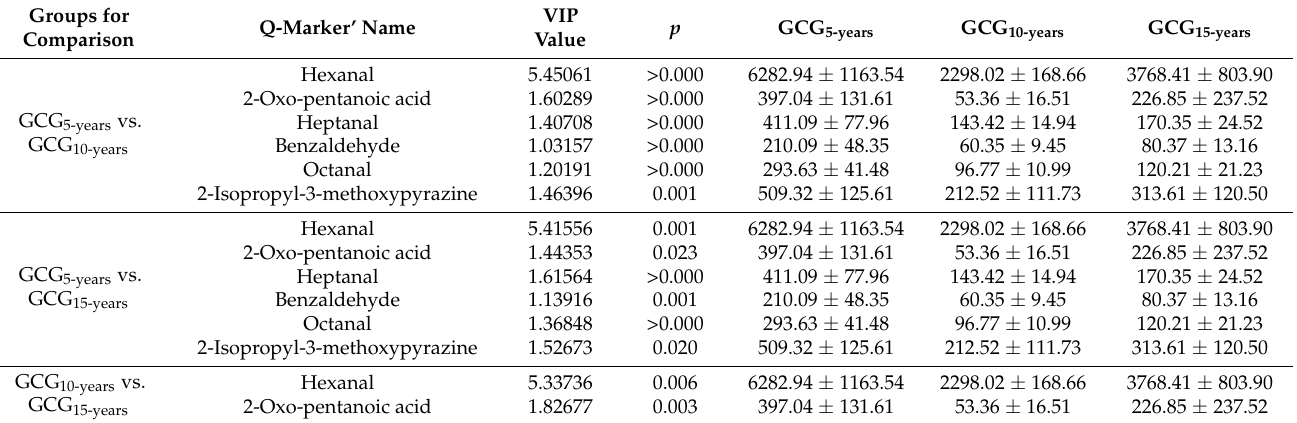
Figure 4. Multivariate statistical analysis base on the volatile components from GCG with 5-, 10-, 15-growth years. ( A ) PCA score plots; ( B – D ) OPLS-DA score plots; ( E – G ) S-plots; ( H ) The con- tents of the five growth-year-dependent markers to distinguish GCG with 5-, 10-, 15-growth years. ( p -value * < 0.1; ** < 0.01; *** < 0.001). Table 4. The detailed information of the six potential chemo-markers among GCG with 5-,10-,15- growth